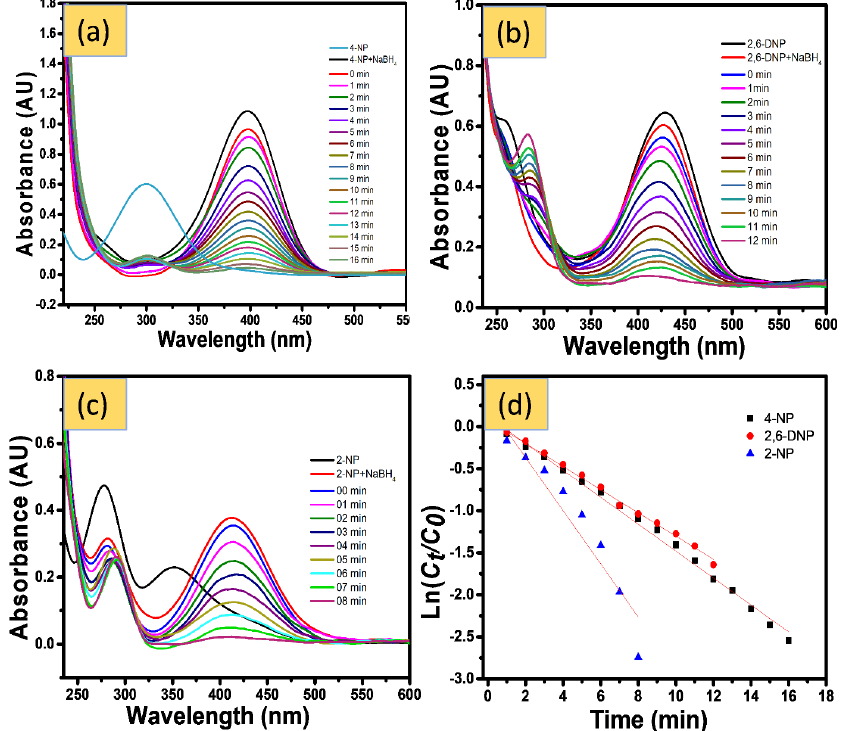
Figure 6. Typical UV − visible absorbance spectra of 4 − NP ( a ), 2,6 − DNP ( b ), and 2 − NP ( c ) and their ( d ) Ln(At/A0) vs. time plot for the reduction reactions where the amount of the Sn-Gd 2 O 3 @GH catalyst was 0.2 g.